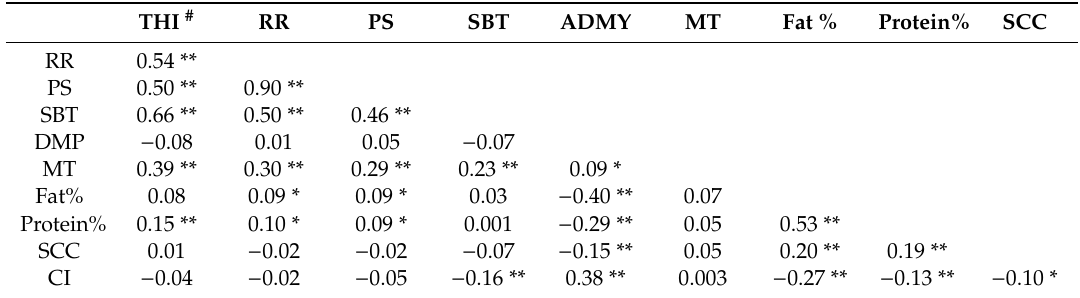
Table 4. Pearson correlation coe ffi cients between THI and milk production and quality